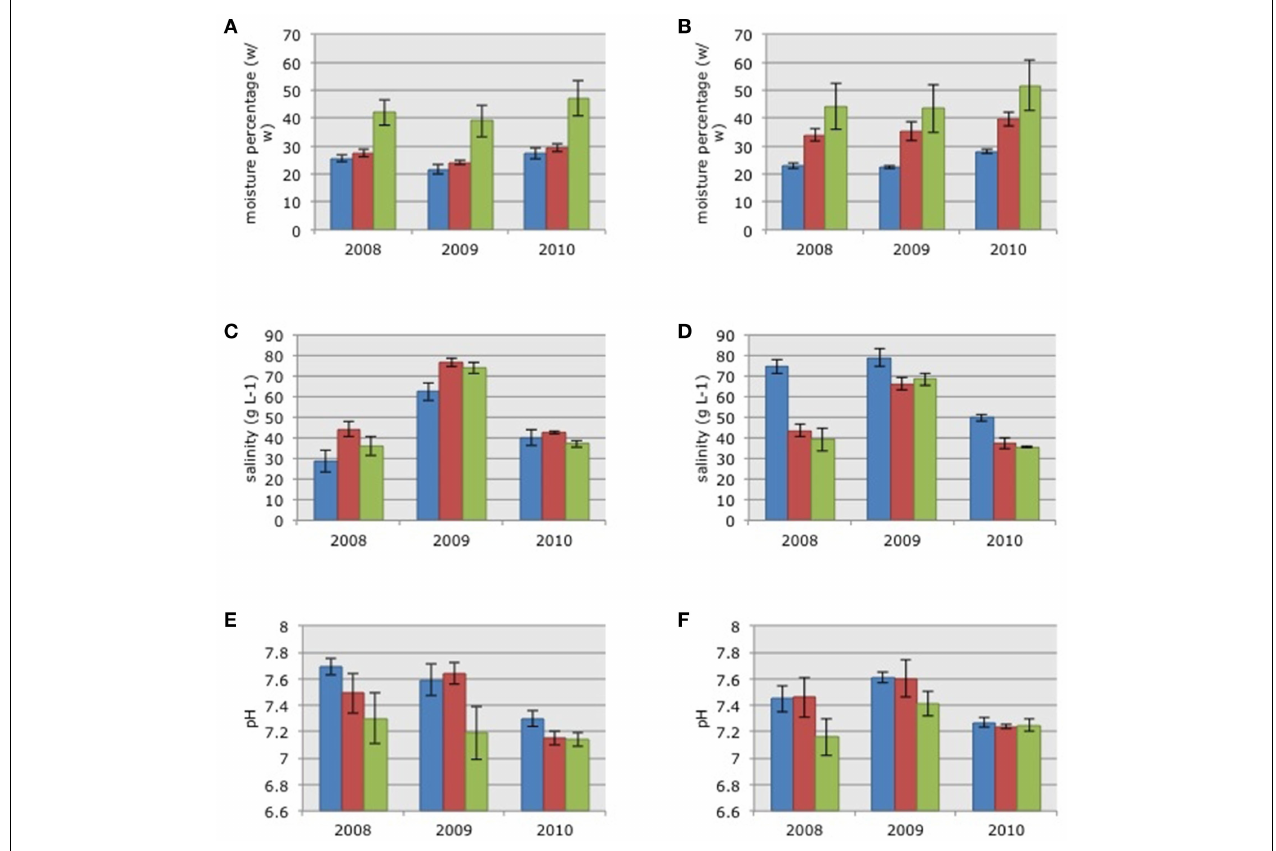
FIGURE 1 |Average soil moisture content (A,B), pore water salinity (C,D), and pore water pH (E,F) in the samples collected in the three habitats in impoundments 23 (A,C,E) and 24 (B,D,F). Mangrove habitats are indicated by different colors: Blue = dwarf, red = sparse, and green = dense; SE in brackets.